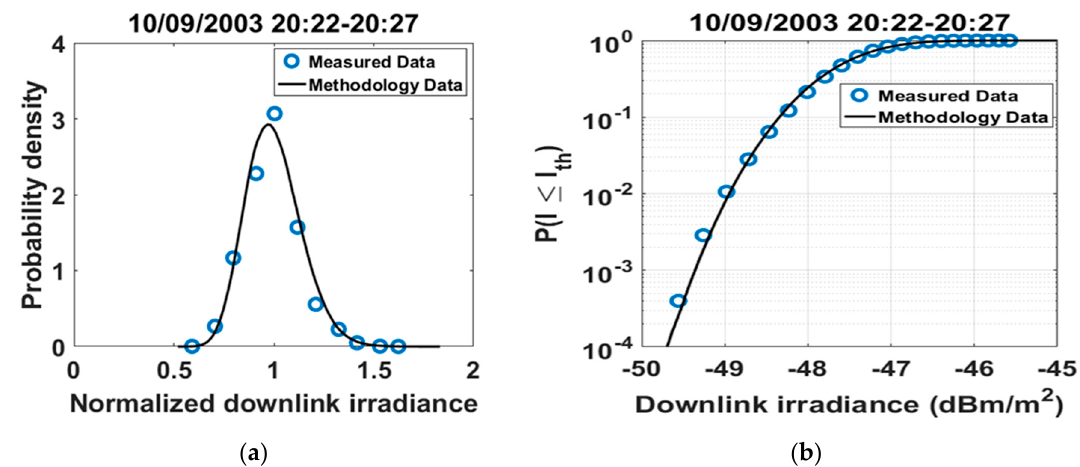
Figure 8. First order irradiance statistics validation for session on 10 / 09 / 2003 20:10. ( a ) Normalized Figure 8. order irradiance statistics validation for session on 10/09/2003 20:10. (a) Normalized PDF of PDF of measured data vs. Normalized PDF of generated data; ( b ) CDF of measured data vs. CDF of measured data vs. Normalized PDF of generated data; (b) CDF of measured data vs. CDF of generated generated data.